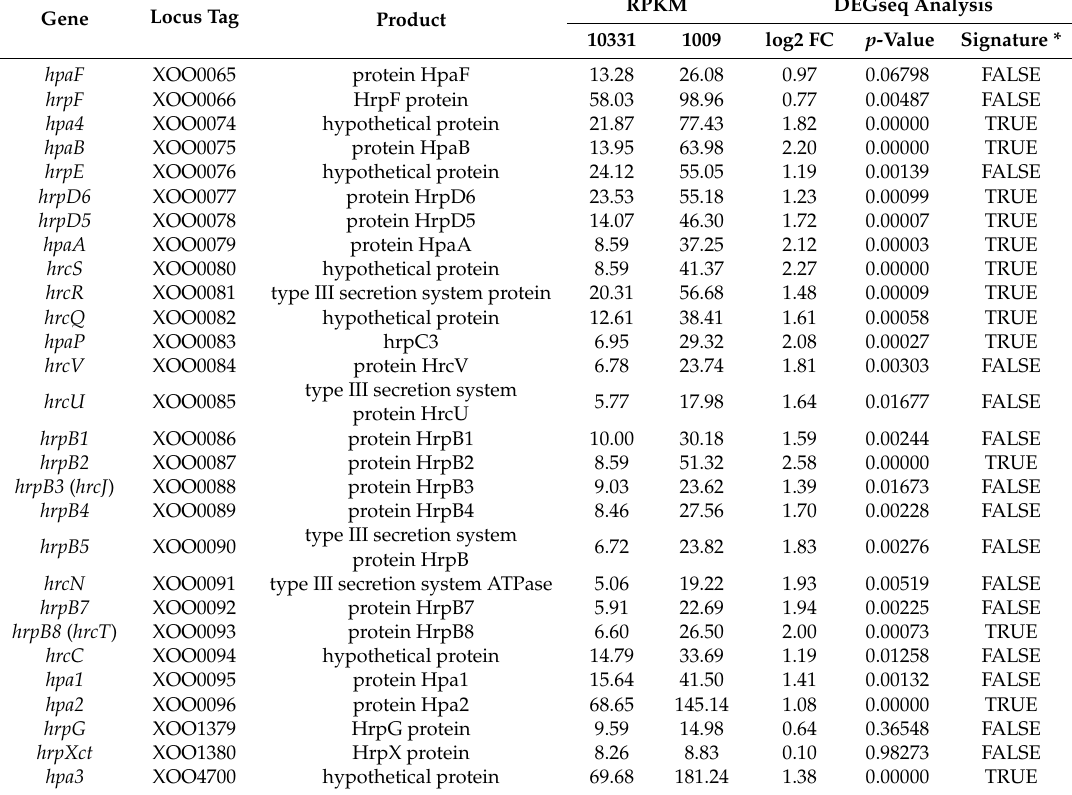
Table 1. Expression profiles of hrp genes in the Xanthomonas oryzae pv. oryzae KACC10331 and HB1009 strains. * True indicates significant differential expression ( p -value <